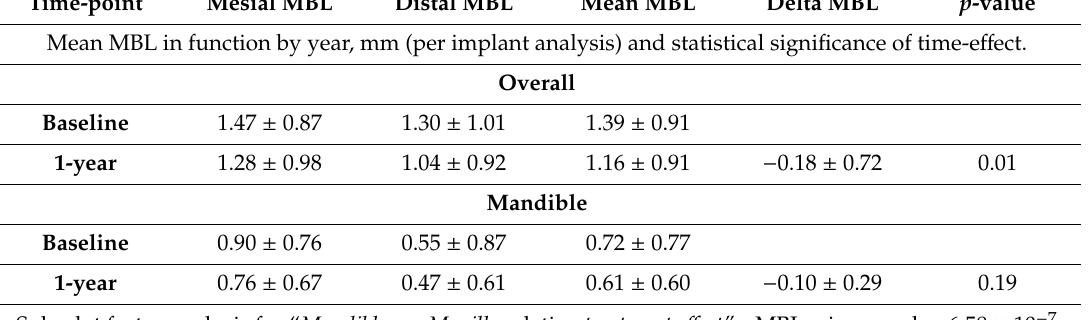
Figure 4. Density plot of the mean marginal bone change frequency distribution one year after loading in the entire cohort. The plot exquisitely shows a bell-shaped curve denoting a predictable amount of marginal bone resorption for the implant-abutment studied: most of the observations converged around zero.